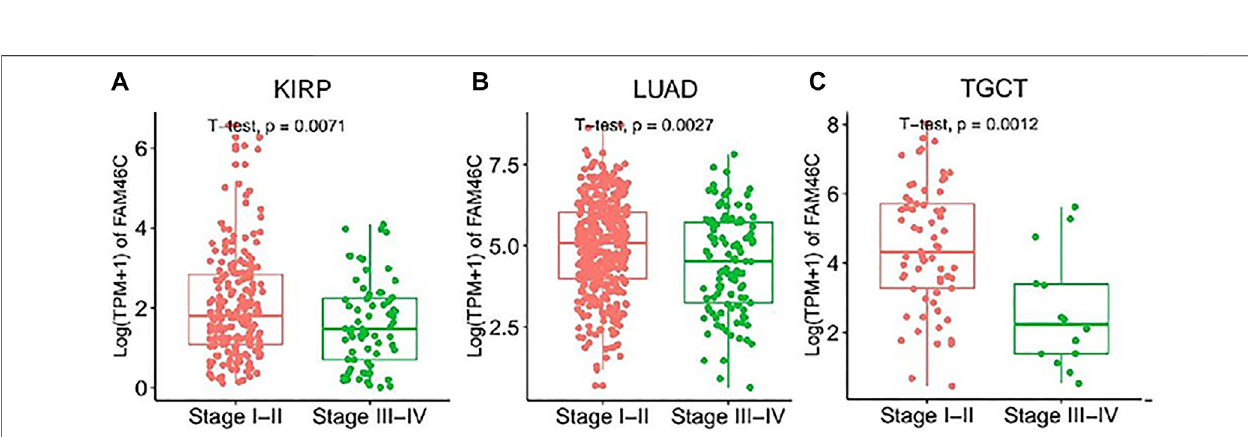
Frontiers in Genetics |